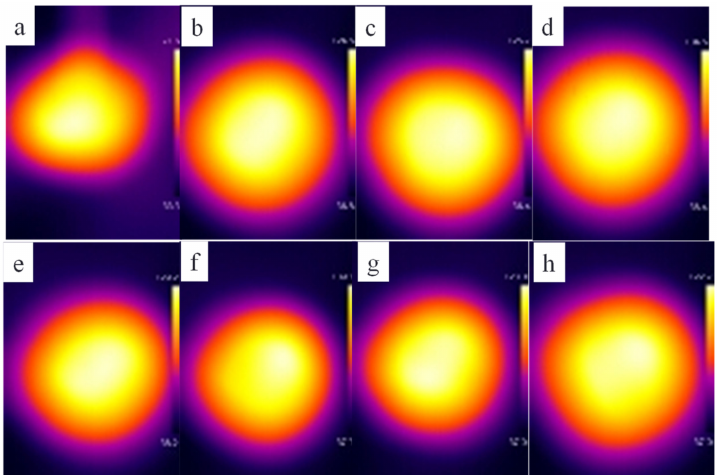
Figure 5. ( a ) Temperatures of the composite films under the condition of near-IR irradiation for 60 s, natural cooling after being turned off and the temperature of the composite film under IR for 60 s ( b ). The insert is a photograph of the tested sample.